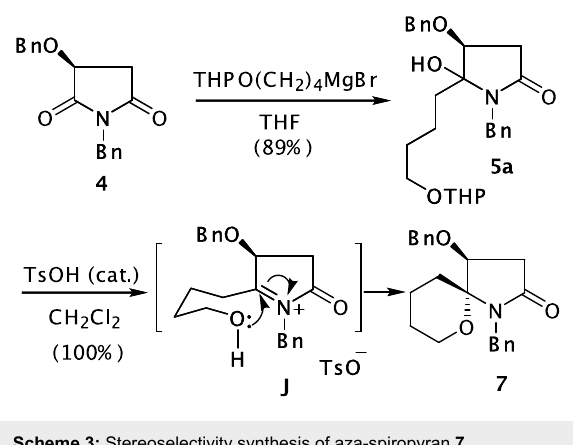
Scheme 2: Synthetic strategy based on N , O -dibenzylmalimide ( 4 ).